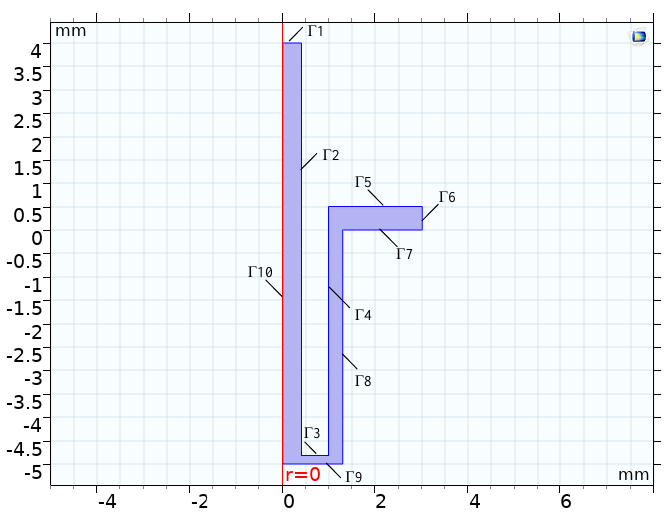
Figure 3. Two-dimensional model and boundary definition of machining area. The temperature distribution and current density distribution in the machining gap under the condition of external 24 V DC voltage and pulse voltage at both ends of the electrode and workpiece are shown in Figures 4 and 5.